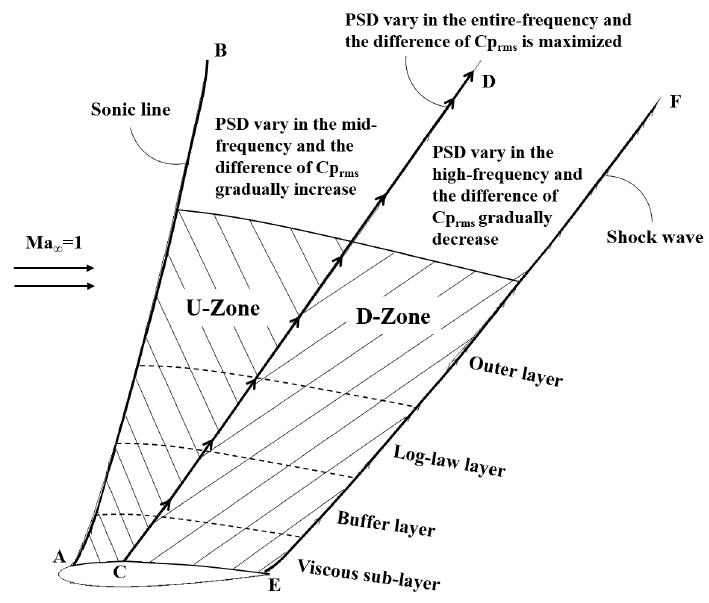
Figure 11. The pressure fluctuation in the U-zone and